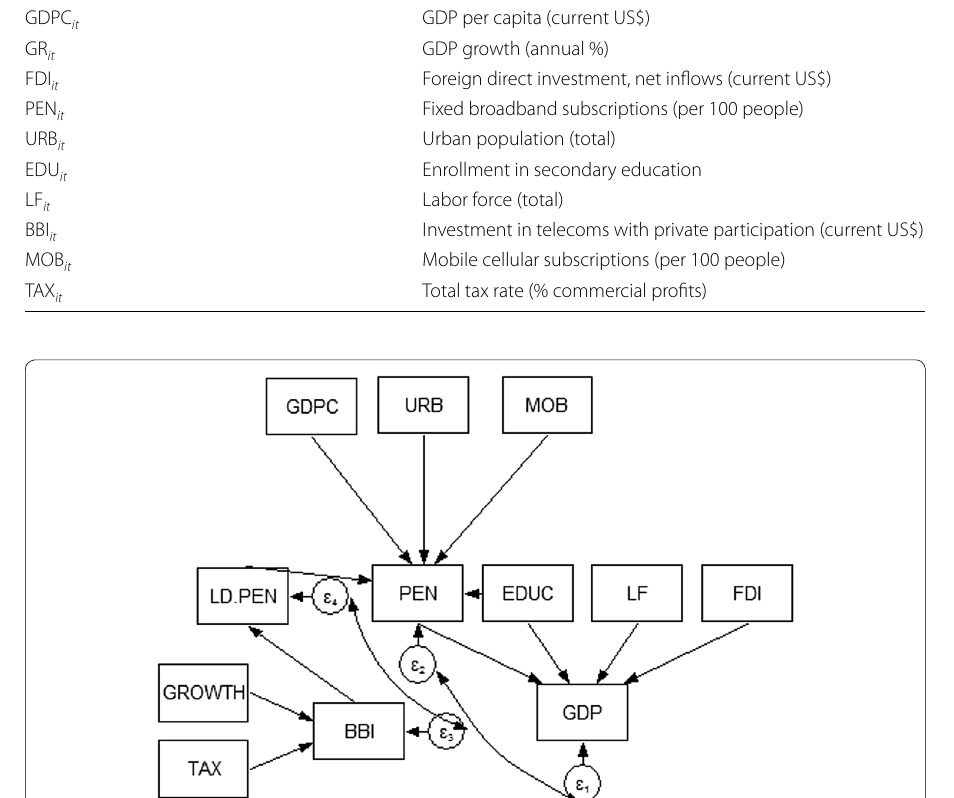
Fig. 1 Structure of the system of